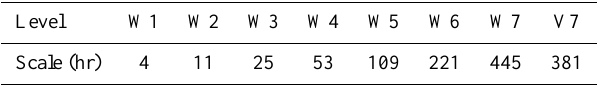
Table 1. Mean event statistics as a function of AMO condition (Park et al., 2010). Water levels are with respect to the 1988 North Amer- ican Vertical Datum (NAVD).